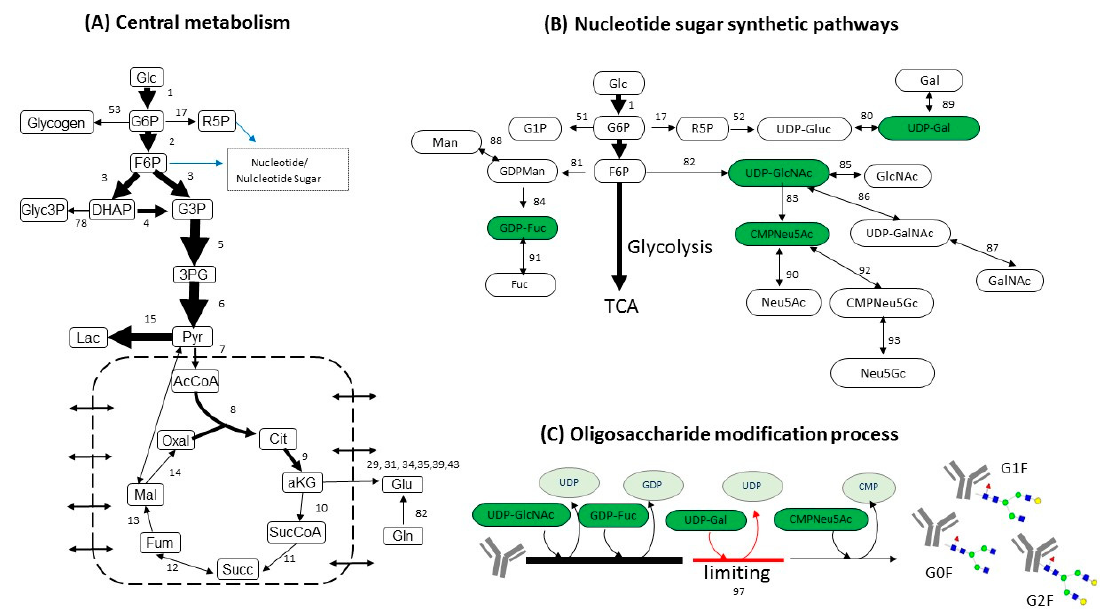
Figure 2. Simplified view of metabolic pathways included in the flux balance analysis (FBA). ( A ) central metabolism; ( B ) nucleotide sugar synthetic pathways; ( C ) oligosaccharide modification process. The numbers of reactions correspond with the ones initially used in Reference [18].